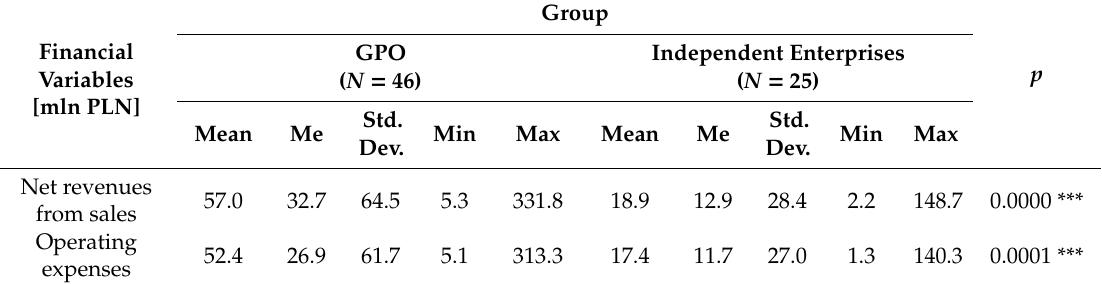
Table 5. Net revenues from sales and operating expenses for the analysed enterprises